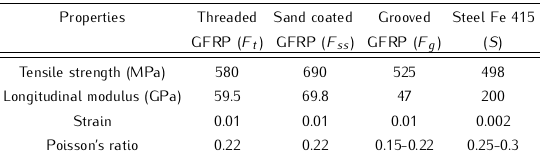
Table 2. Properties of reinforcements.